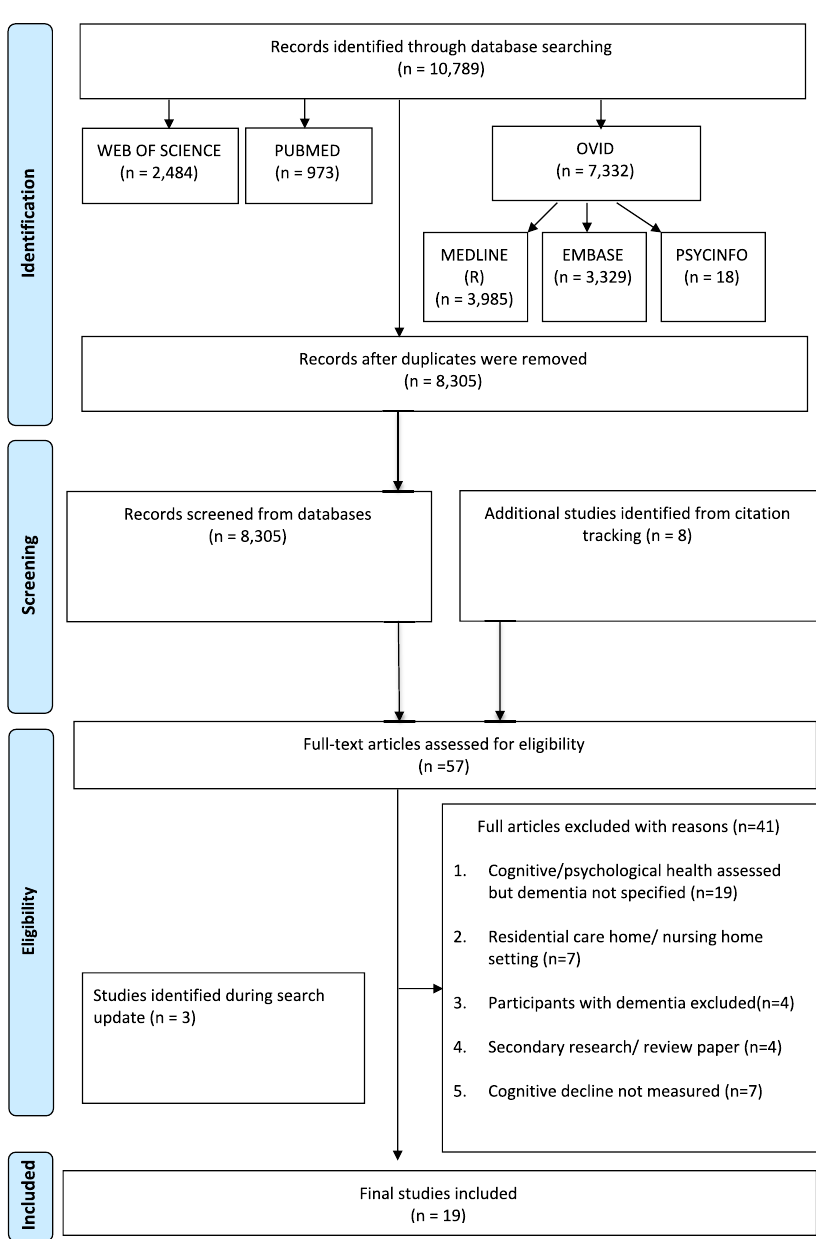
Fig. 1 Prisma fl ow chart outlining literature